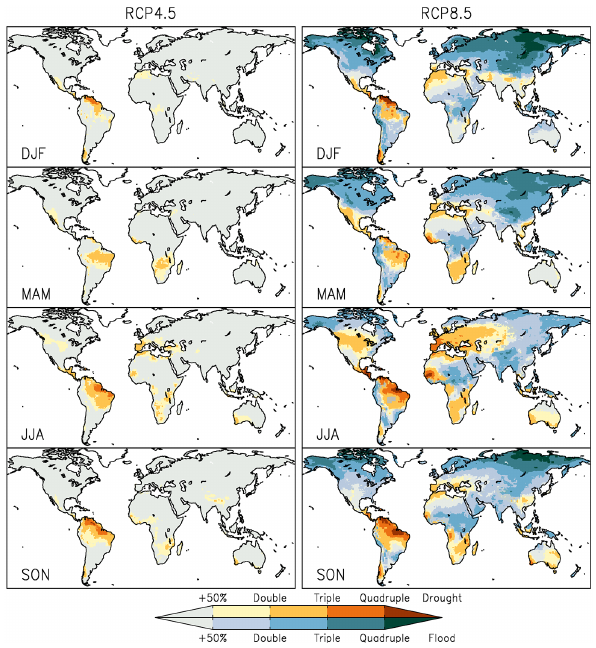
Figure 3. As in Fig. 1 for basin-average runoff from the 100 largest river